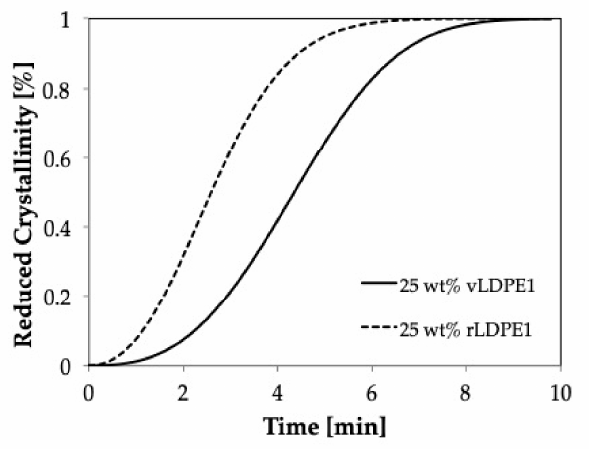
Figure 9. Crystallinity obtained at 139 ◦ C for virgin material (vPP1 / vLDPE1) and recycled material (rPP1 / rLDPE1) blends containing 25 wt % of vLDPE1 and rLDPE1, respectively.